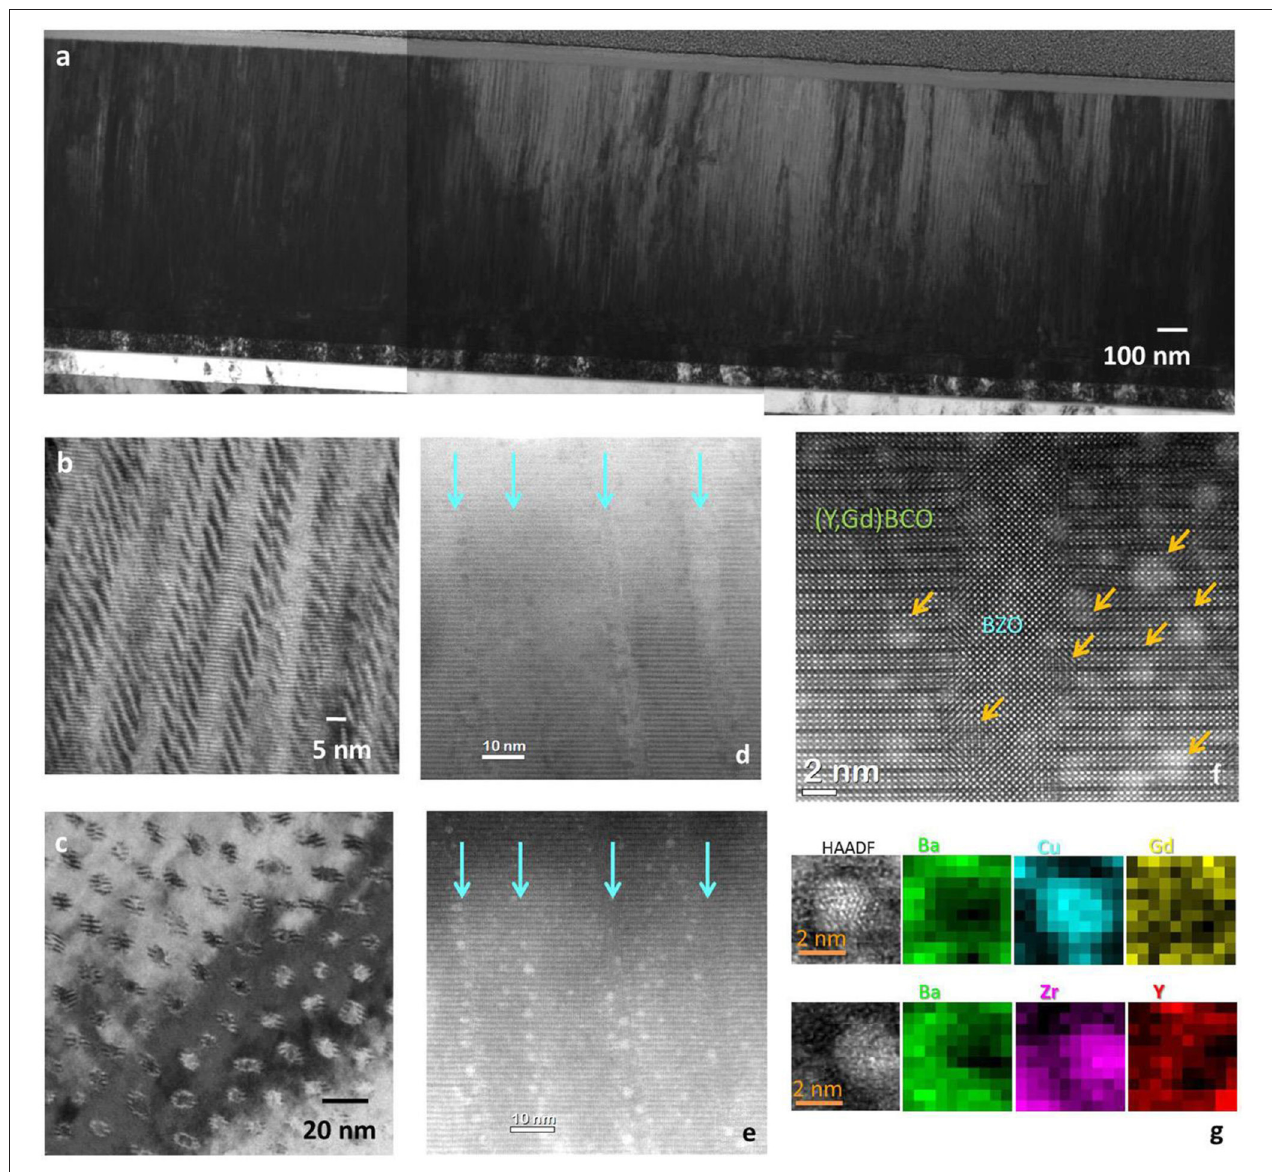
FIGURE 12 | Cross-sectional TEM image of a (Gd, Y)BCO film with 25 mol% Zr on IBAD grown by MOCVD technique. (a,b) Show that BZO nanocolumns are formed which are about 5nm in diameter and aligned along the crystallographic c -direction. Planar view of the microstructure is shown in (c) , whereas (d–f) show the bright-field image, high angle annular dark field image and high-resolution cross-sectional image. The compositional map of a nanoparticle is conducted by electron energy loss spectrometer and is shown in (g) . Reprinted from Selvamanickam et al. [113], with the permission of AIP